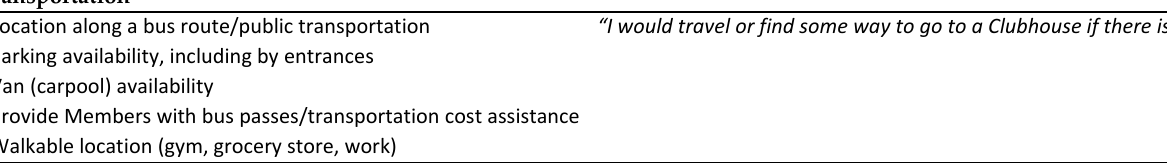
Figure 2. A summary of Member responses to participatory exercises.